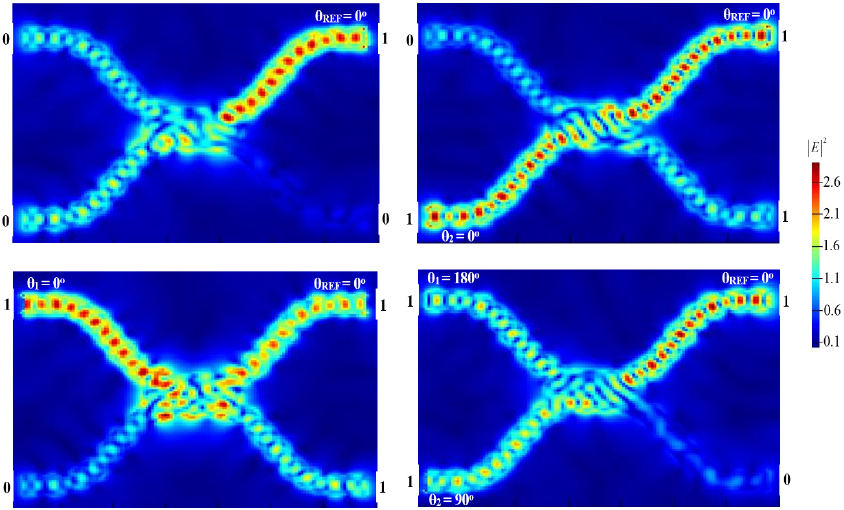
Figure 8. Light field distributions for XOR function utilizing 2 × 2 silicon waveguide at 1.55 μ m.